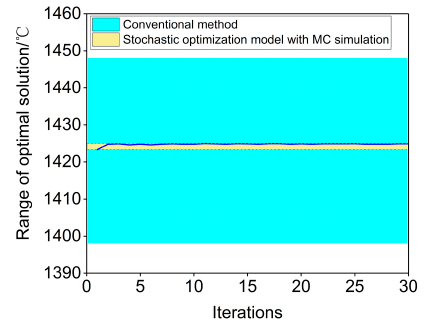
Figure 12. Comparison of the range of optimal solutions obtained by the conventional method and our stochastic optimization model.